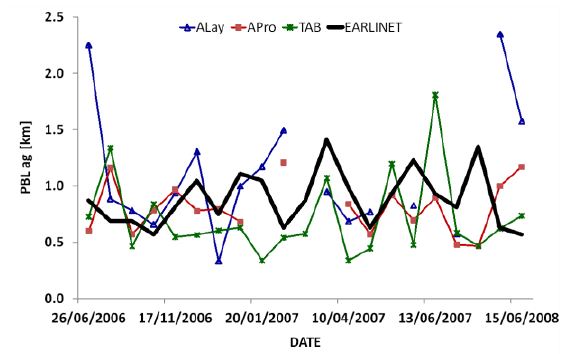
Figure 2. Temporal series of CALIPSO retrieved and EARLINET derived PBL